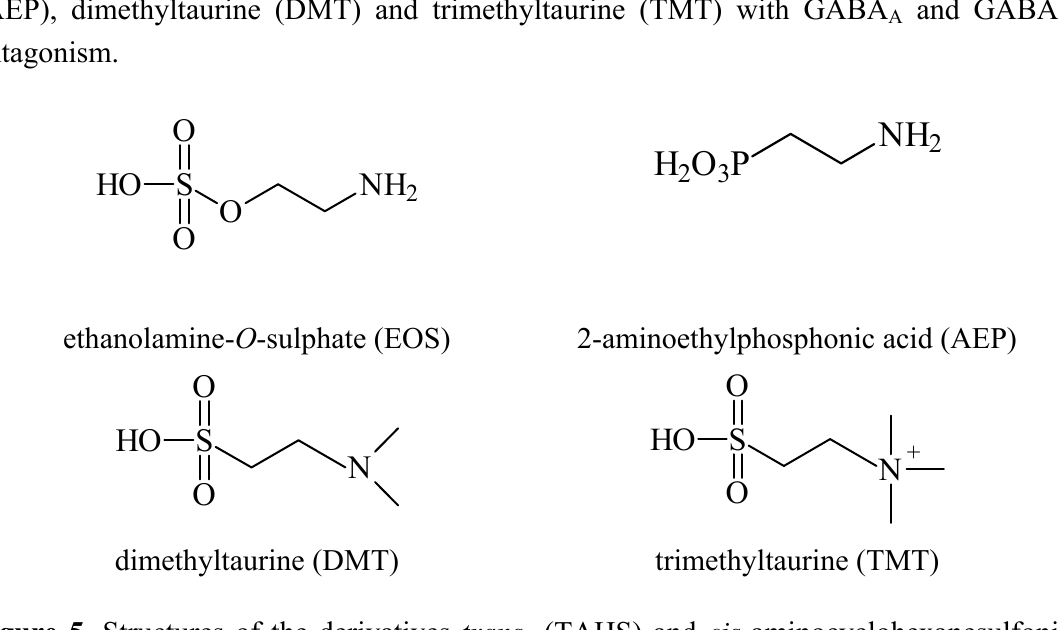
Figure 5. Structures of the derivatives trans- (TAHS) and cis -aminocyclohexanesulfonic acid (CAHS).